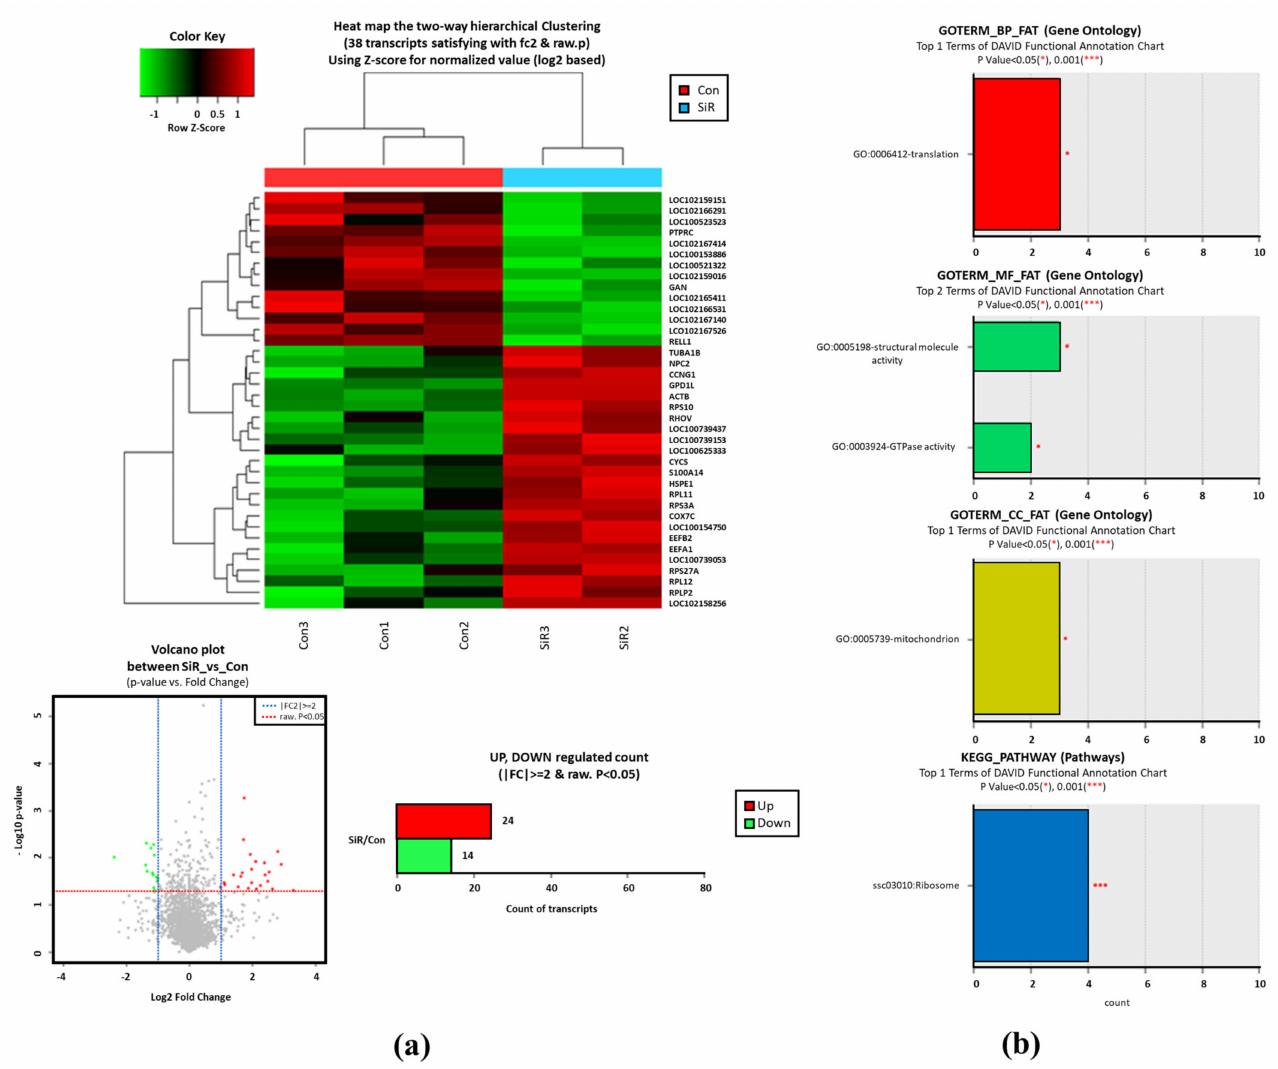
Figure 2. Hierarchical cluster, volcano plots and Gene ontology (GO) analysis of differentially ex- pressed genes (DEGs; P -adjusted < 0.05 and log 2 fold change) between uninjected parthenogenetic blastocysts (con.) and cd26-siRNA-injected parthenogenetic blastocysts (SiR.). Red and green blocks represent upregulated and downregulated genes, respectively; the color scale of the heatmap repre- sents expression levels, where the brightest green stands for − 1.0 log 2 fold change and the brightest red stands for 1.0 log 2 fold change. The 38 DEGs were selected based on the least standard deviation within a group ( a ). Functional analyses (GO and KEGG pathway) showed that DEGs were enriched in certain biological processes (BP), molecular functions (MF), and cellular components (CC), as well as ribosome-linked pathways ( b